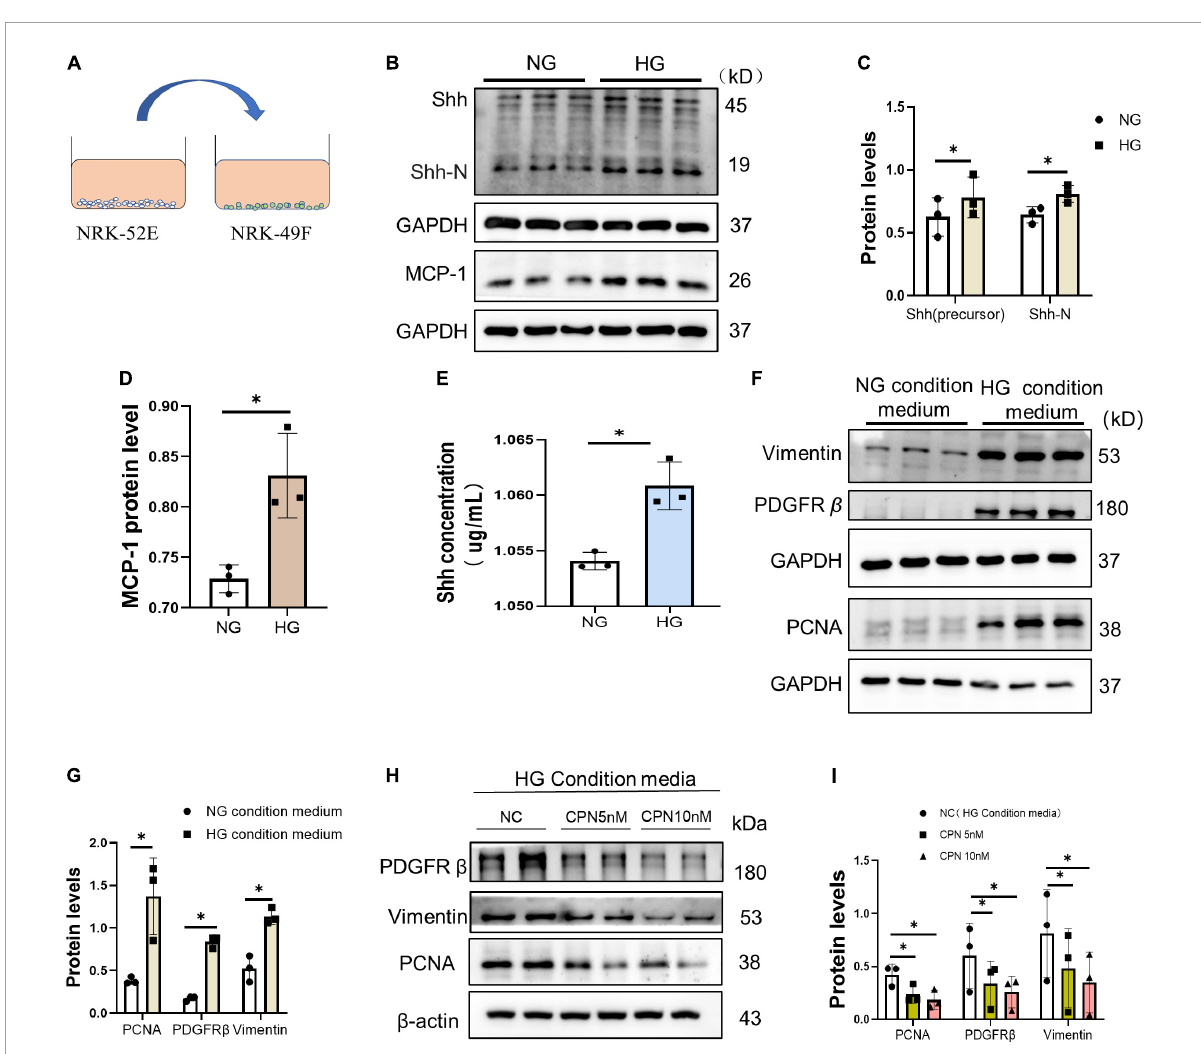
FIGURE6 Activation and proliferation of fibroblasts stimulated by HG condition medium. (A) Schematic diagram of NRK-49F cell culture with supernatant of condition medium. (B–D) Western blot analyses showed Sonic hedgehog (Shh) and p21 protein in each group. Representative Western blot (B) and quantitative data (C,D) are presented. (E) Shh was detected by enzyme-linked immunosorbent assay (ELISA) in condition medium of each group. (F,G) NRK-49F cells were cultured with condition medium for 72 h. Western blot analysis showed Vimentin, proliferating cell nuclear antigen (PCNA), and PDGFR- β protein in each group. Representative Western blot (F) and quantitative data (G) are presented. (H,I) NRK-49F cells cultured in the condition medium with or without CPN (5 nM, 10 nM). Western blot analysis showed Vimentin, PCNA, and PDGFR- β protein in each group. Representative Western blot (H) and quantitative data (I) are presented. All data are presented as mean ± standard deviation (SD) from three independent experiments. n = 3; ∗ P < 0 05 vs. NC